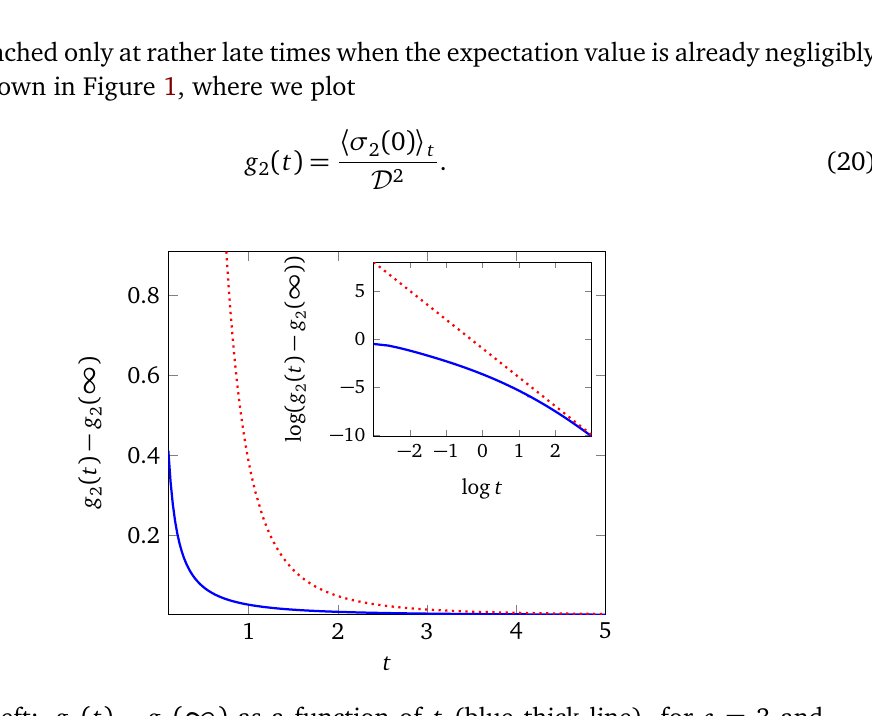
( t ) − g ( ∞ ) as a function of t (blue thick line), for c = 3 and Figure 1: Left: g 2 2 D = 0.16. The dotted red line is the result for the leading asymptotics ∝ t − 3 . The inset shows the same quantities on a logarithmic scale.